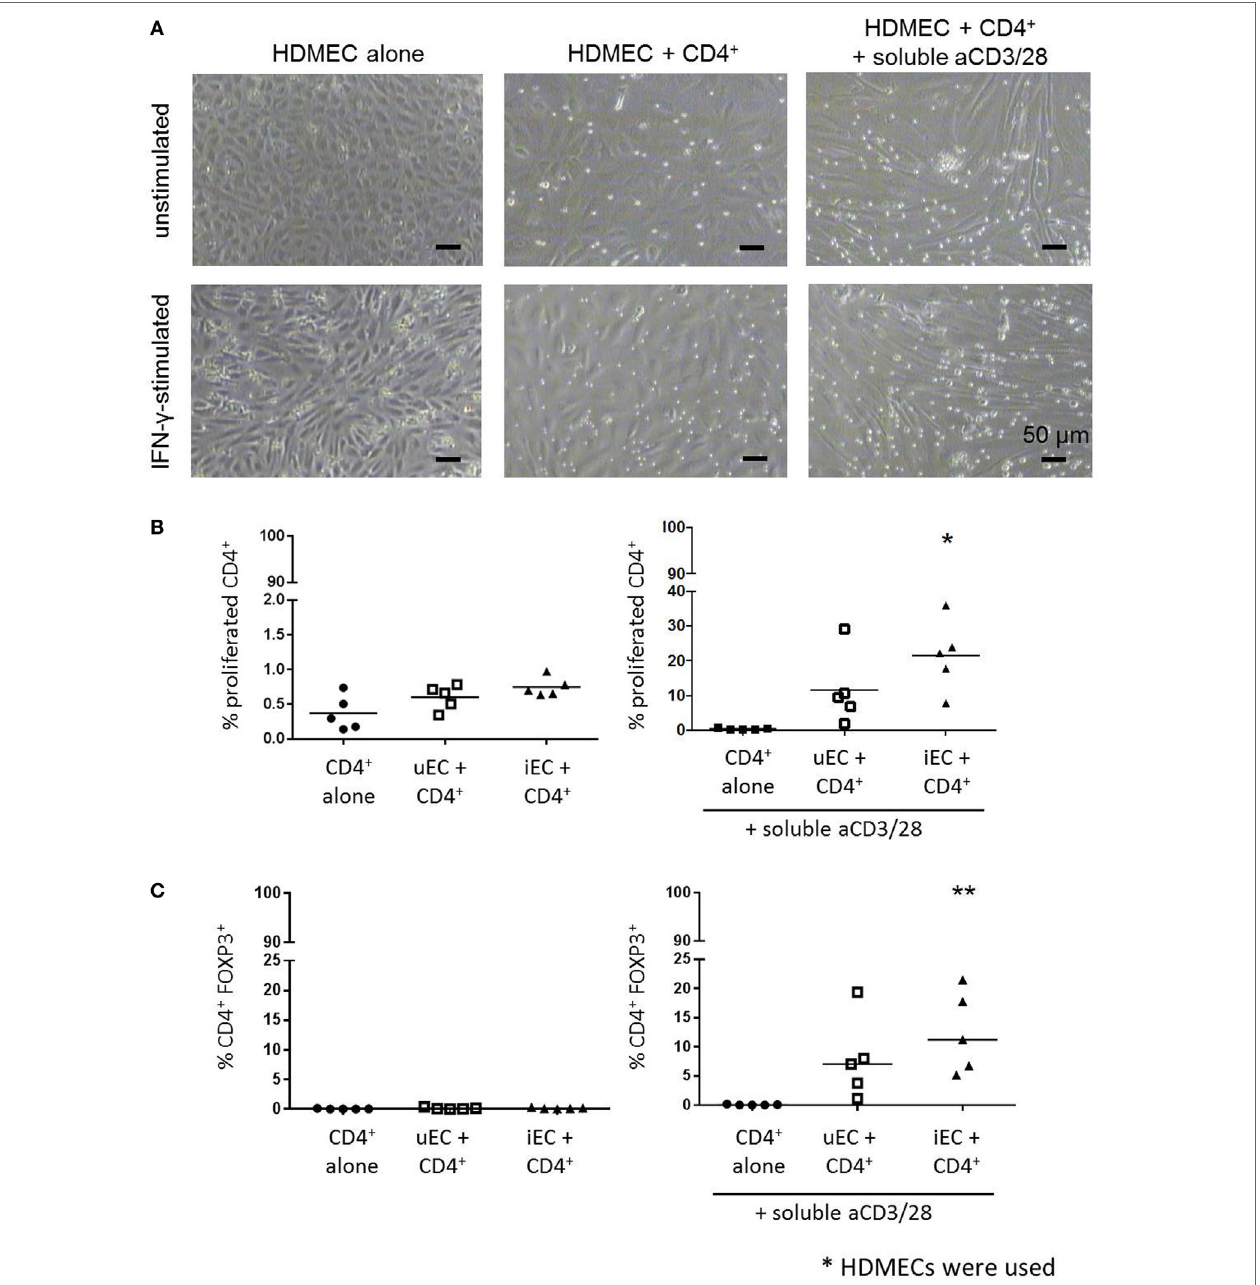
FigUre 2 | Proliferation of CD4 + T cells in HDMEC cocultures and their expression of FOXP3. (a) Phase contrast micrographs of HDMEC-CD4 + T cell cocultures using unstimulated or interferon (IFN)- γ -stimulated HDMECs in the absence or presence of stimulatory aCD3/28 antibodies were taken at 72 h; micrographs were taken at 100 × original magnification; scale bar of 50 µm included. (B) CFSE-labeled CD4 + T cells were cocultured with HDMECs used either unstimulated (uEC) or stimulated with 10 U/mL IFN- γ (iEC) for 24 h; proliferation of CD4 + T cells was analyzed by CFSE dilution at 72 h. Proliferation of CD4 + T cells in HDMEC-CD4 + T cells cocultures stimulated with aCD3/28 antibodies were also measured. One-way analysis of variance (ANOVA) with Dunnett’s test was conducted; * P < 0.05 cf. control, n = 5. (c) FOXP3 expression of proliferated CD4 + T cells from the same HDMEC-CD4 + T cell cocultures was also analyzed at 72 h, where data are expressed as percentage of CD4 + FOXP3 + cells from the total CD4 + population with means shown. One-way ANOVA with Dunnett’s test was used; ** P < 0.01 cf. control; n =